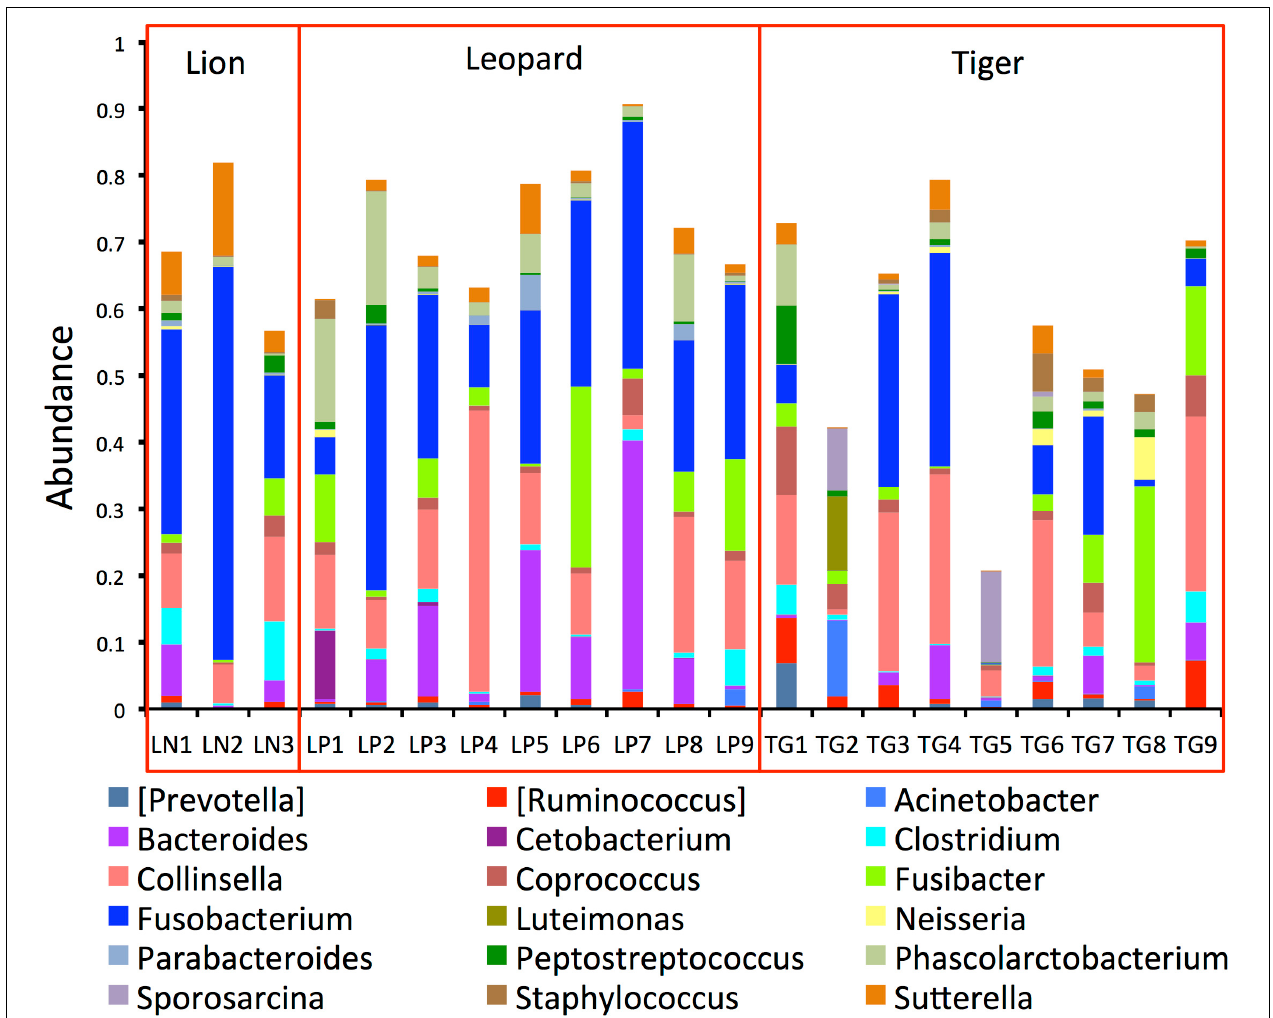
FIGURE 2 | Bar plots showing the topmost abundant bacterial genera present in the Panthera gut microbiome. The genera with more than 1% abundance are